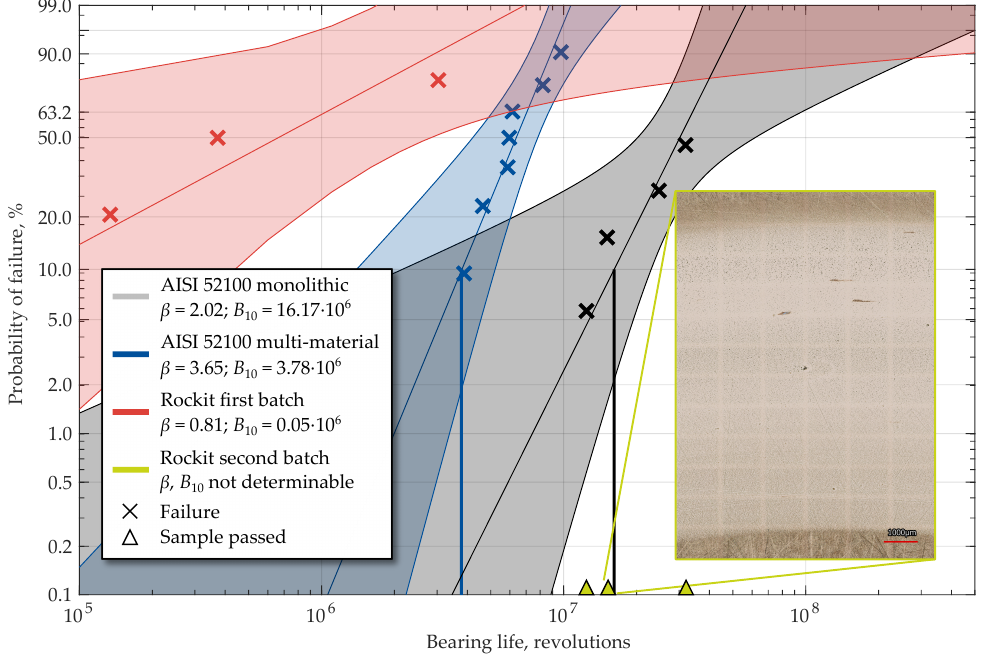
Figure 10. Weibull plot of Tailored Forming bearing